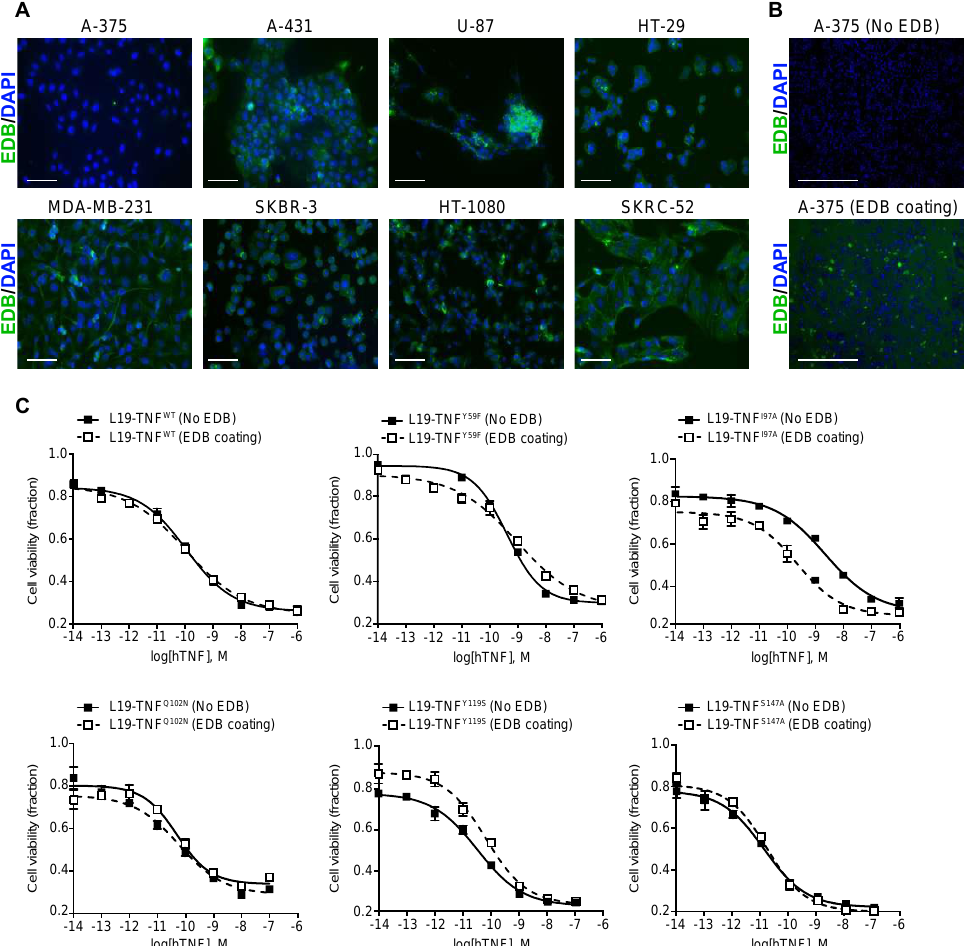
Figure 3. Assessment of EDB expression by different human tumor cell lines and in vitro biocidal activity of L19-TNF mutants. ( A ) Immunofluorescence analysis of EDB expression on different human tumor cells. All tumor cells showed high EDB expression, with the exception of the A-375 cell line. Green = EDB, Blue = Nucleus. Scale bar = 100 µ m. ( B ) Immunofluorescence EDB staining results on A-375 cultured in absence or presence of recombinant EDB coating. ( C ) In vitro cytotoxicity of L19-TNF wild type and mutants assayed on A-375 cells in the presence (dashed line) or absence (continuous line) of EDB coating. L19-TNF I97A showed conditional cytotoxicity in the presence of EDB. Data points represent cell viability (mean ± SD, n = 3). Table 1. Calculated EC 50 values for L19-TNF wild type and mutants.